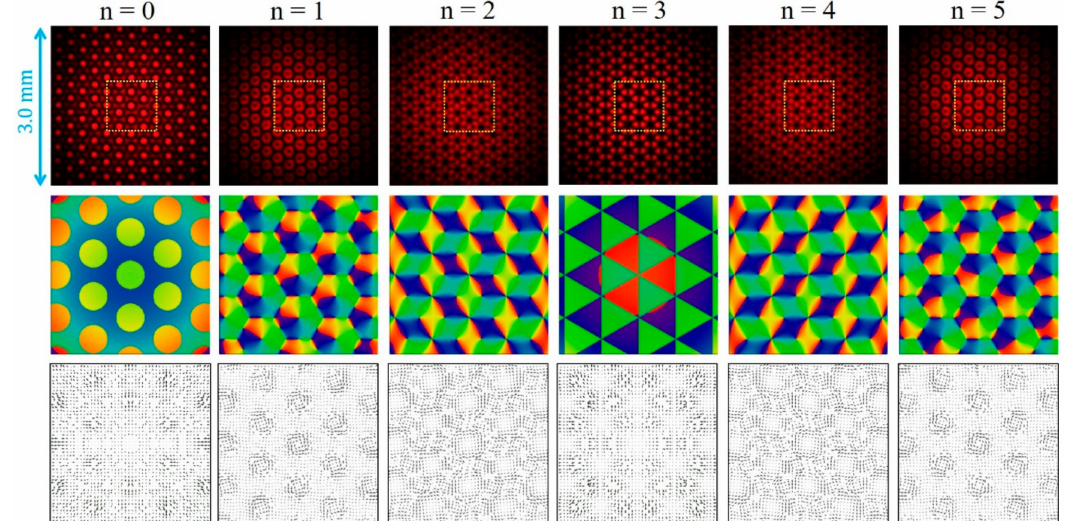
Figure 4. Experimental crystalline patterns (the first row) for the case of Q = 6. The contour plots of the phase fields Θ ( ρ , φ ; θ n ) (the second row) for the boxed region in the first row. The last row: the probability current density corresponds to the second row.